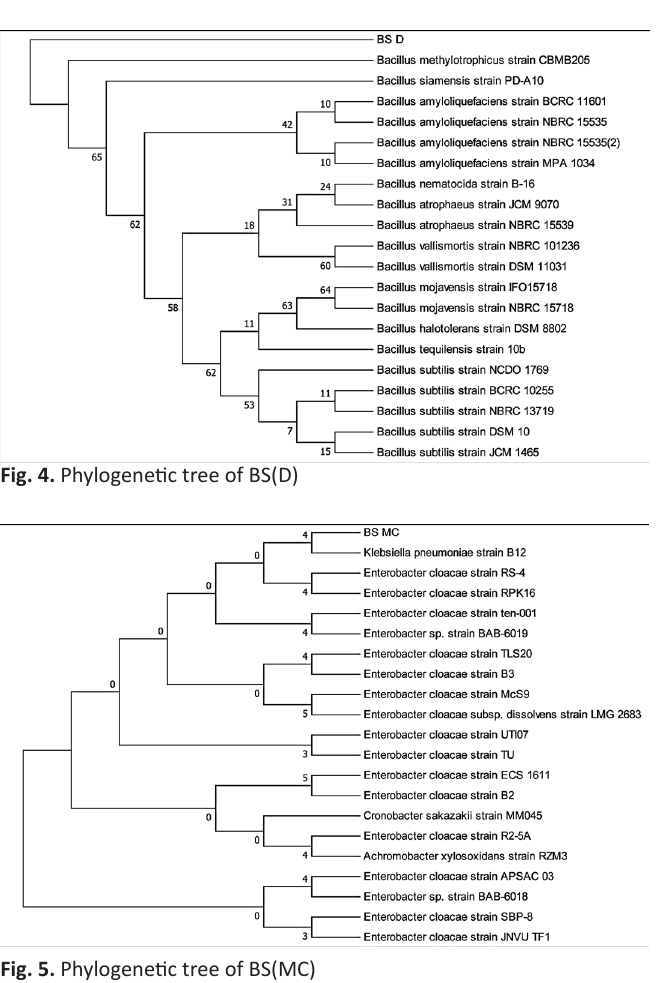
Fig. 5. Phylogenetic tree of BS(MC)